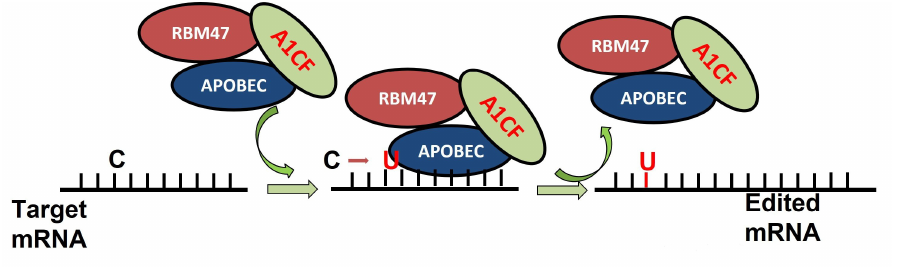
Figure 4. RNA-binding protein RBM47 is required for normal Cytidine to Uridine RNA editing in mammals and is sufficient for the C to U RNA editinf activity of APOBEC demainase domain